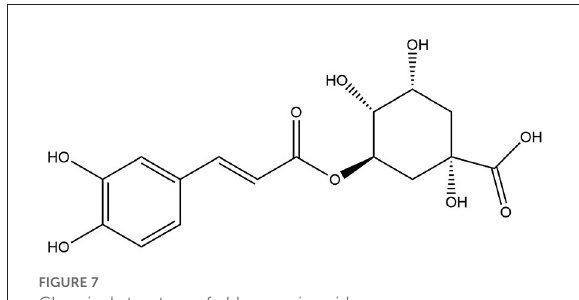
FIGURE7 Chemical structure of chlorogenic